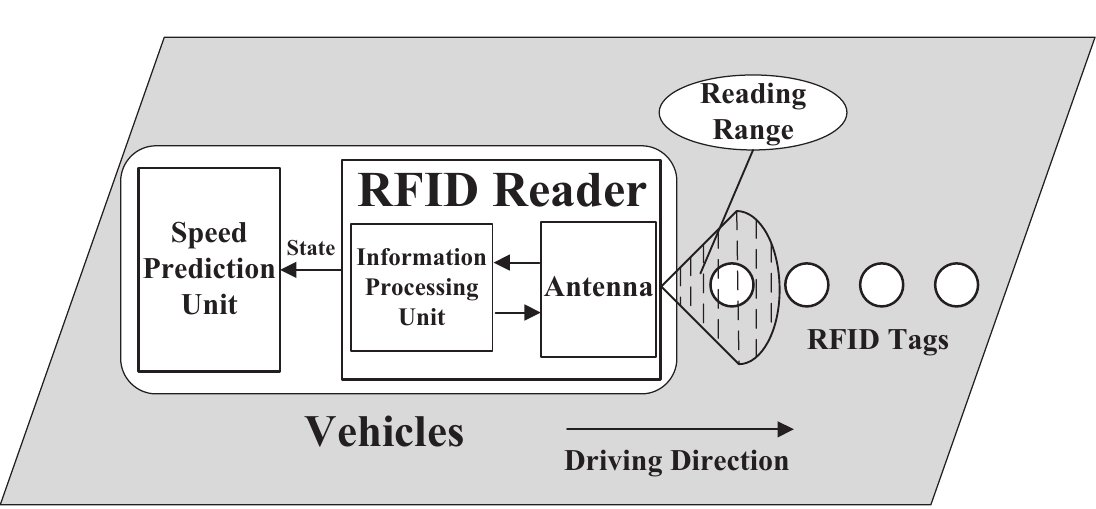
Figure 1. The diagram of RFID data-driven vehicle speed prediction